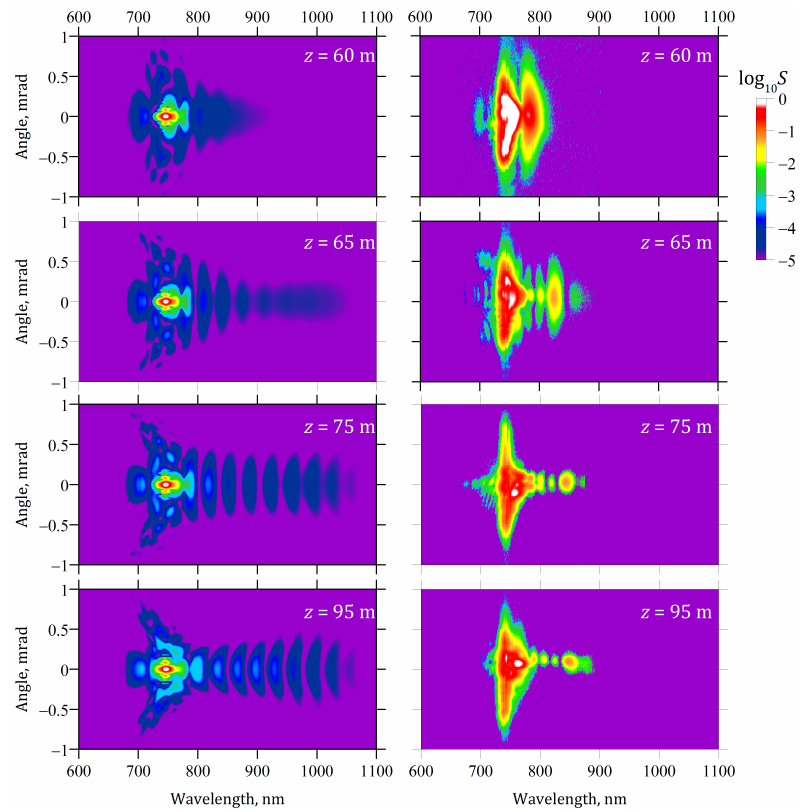
Figure 5. The angle-wavelength spectra obtained in numerical simulations ( left column ) and in the experiment ( right column ) at the distances from 60 m to 95 m.